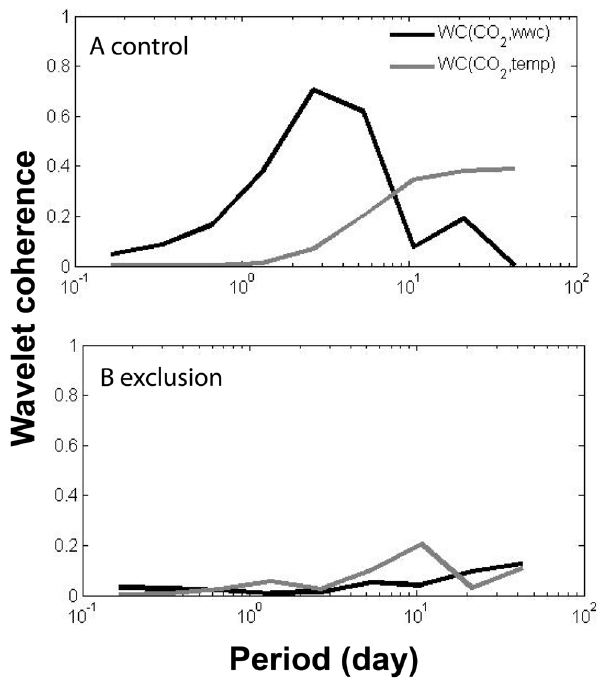
Figure 1. The wavelet coherence [ 44 ] between CO 2 efflux and soil moisture (black) and temperature (gray) in the (A) control and (B) exclusion plots.